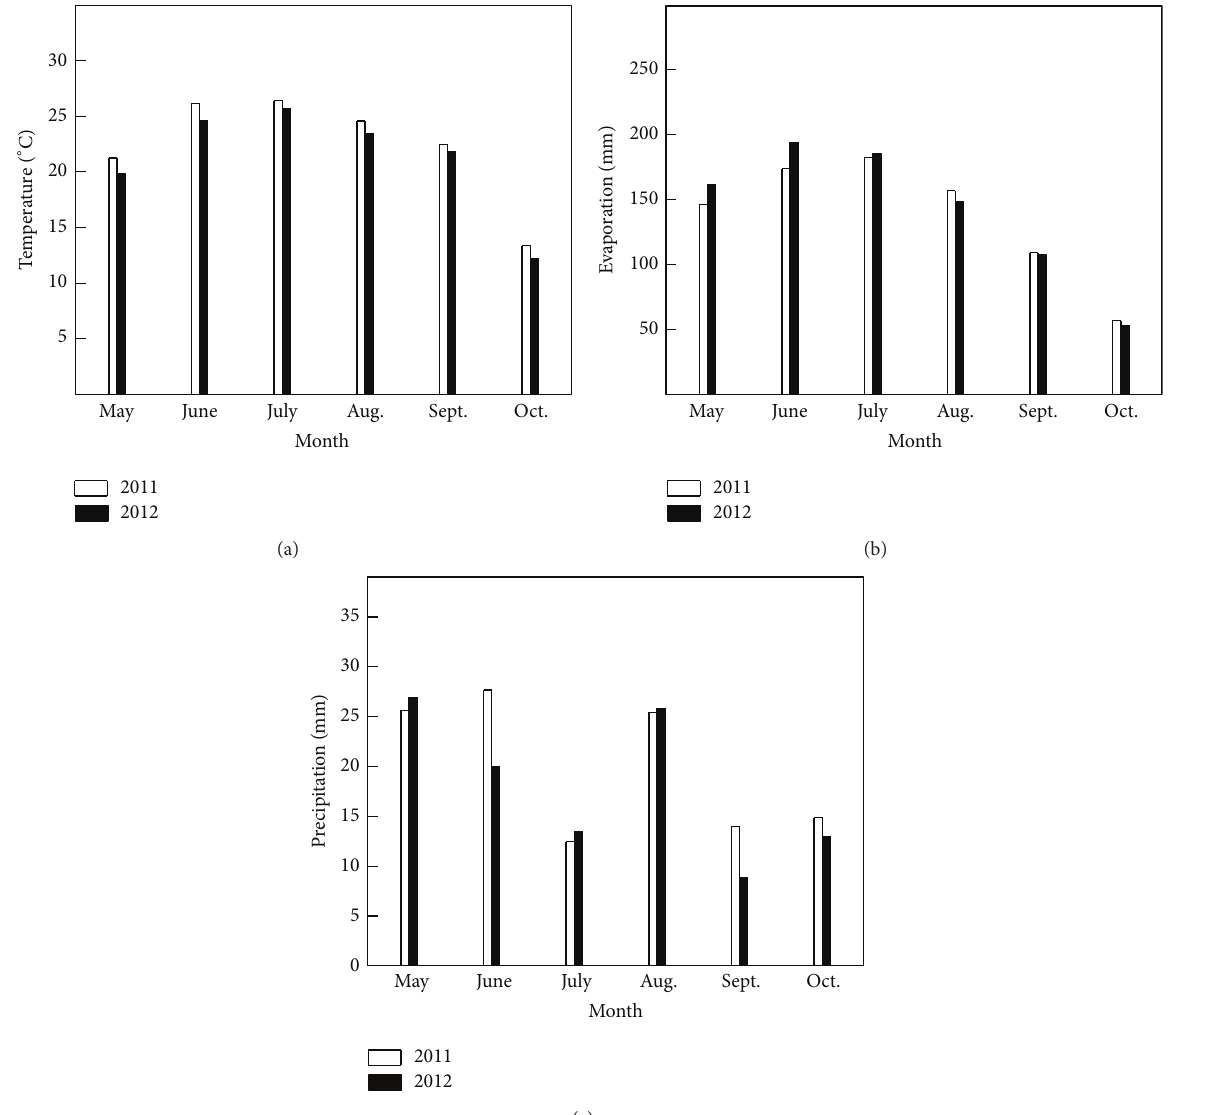
Figure 1: Average temperature (a), evaporation (b), and precipitation (c) during the rice growing period in Shihezi in 2011 and 2012. Each datum point represents the mean of a